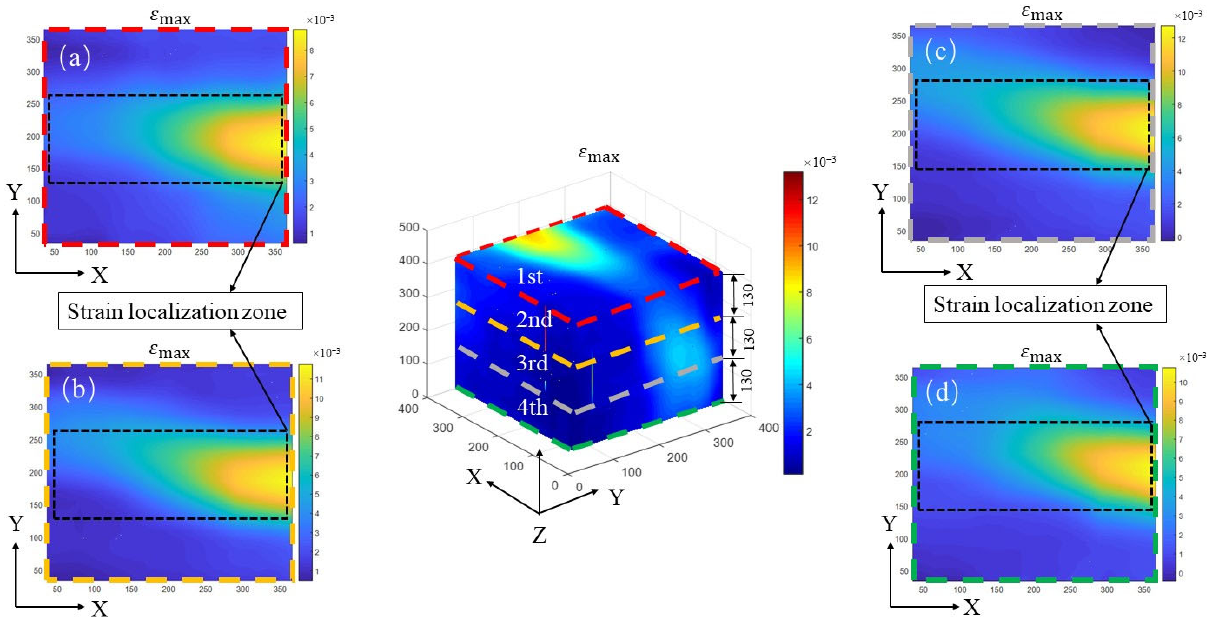
Figure 13. Principal strain map of different sections under 30 MPa. ( a ) the first section; ( b ) the second section; ( c ) the third section; ( d ) the fourth section.